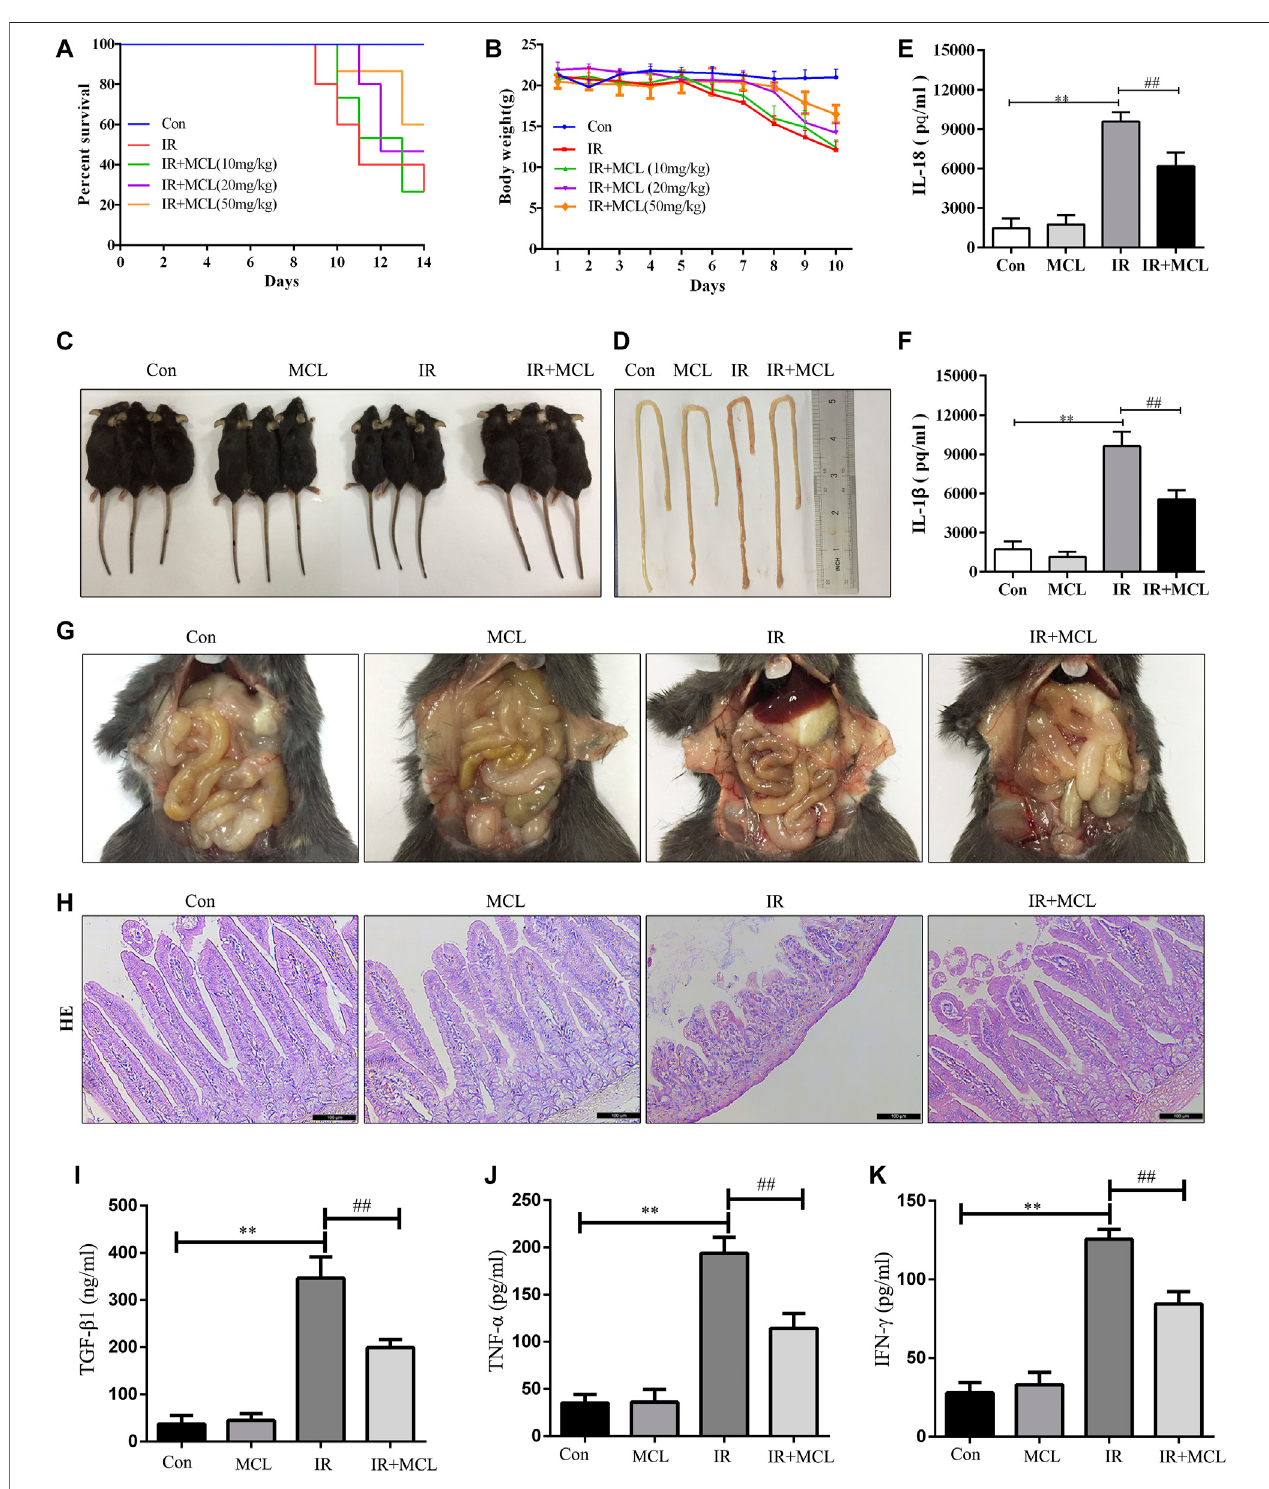
FIGURE 2 | Micheliolide (MCL) attenuates radiation-induced intestinal toxicity and in fl ammatory responses in wild-type (WT) mice (A) Survival curves of all experimental groups following radiation (B) Weight loss following radiation exposure (C) Representative images of mice following radiation (D, G) Representative macroscopic appearance of the small intestine following radiation with MCL treatment (E) Serum interleukin (IL)-18 levels (F) Serum IL-1 β levels (I) Serum TGF- β 1 levels (J) Serum TNF- α levels (K) Serum IFN- γ levels (H) Representative intestinal hematoxylin and eosin staining. Con, untreated WT mice; IL, interleukin; IR, irradiation group; MCL (10 mg/kg)+ IR, mice pre-treated with MCL (10 mg/kg) prior to irradiation; MCL (20 mg/kg)+ IR, mice pre-treated with MCL (20 mg/kg) prior to irradiation; MCL (50 mg/kg)+ IR, mice pre-treated with MCL (50 mg/kg) prior to irradiation; MCL + IR, mice pre-treated with MCL (50 mg/kg) prior to irradiation; and MCL, mice treated with MCL (50 mg/kg) without irradiation. N (cid:1) 15/group. * p < 0.05, ** p < 0.01, *** p < 0.001, **** p < 0.0001, two-tailed Student ’ s t-test.